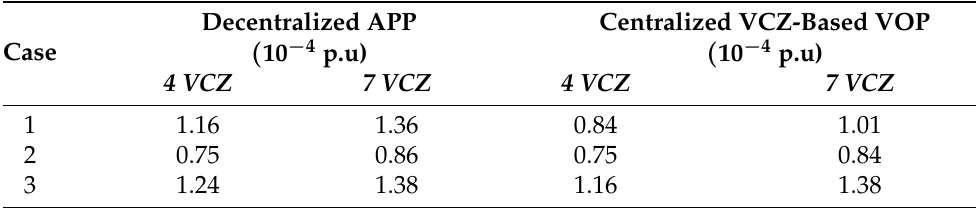
Table 8. Final values of the objective function for Decentralized APP and Centralized VCZ-based VOP with the partitioning in four and seven VCZs.